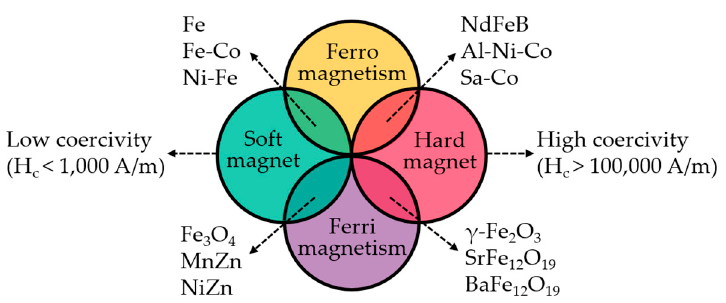
Figure 2. Classification of magnetic materials.